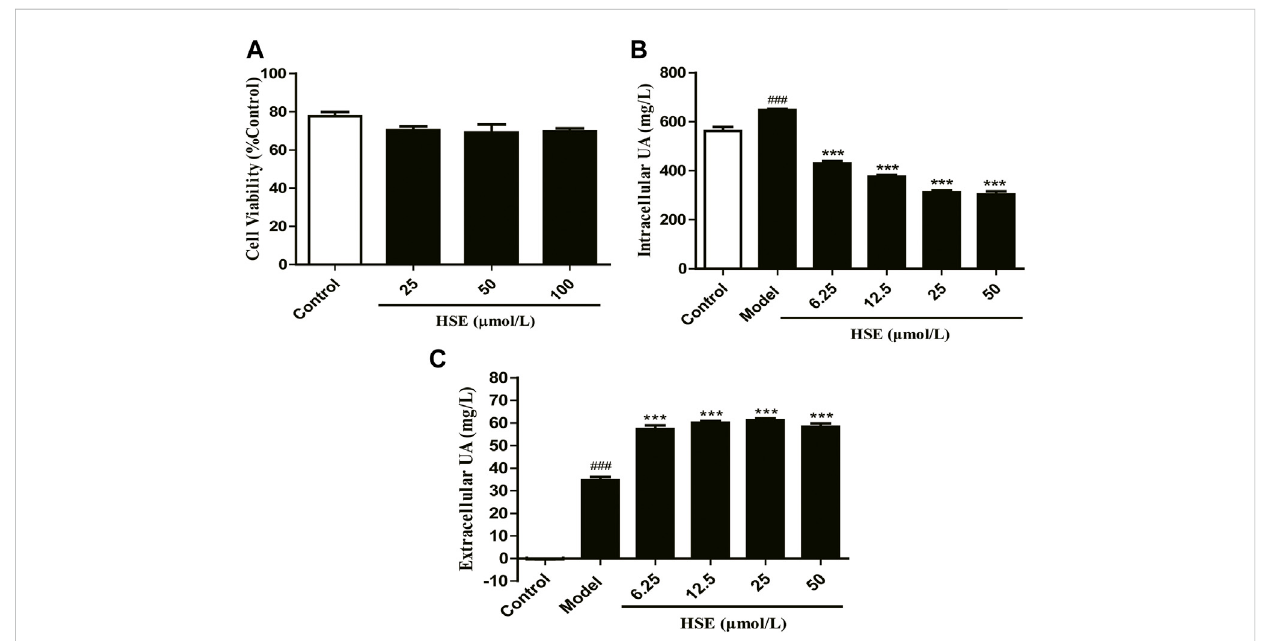
FIGURE 9 Hesperetin(HSE)promoteduricacid(UA)excretion invitro .Effectsofhesperetin(HSE)ontheviabilityofHEK293Tcells (A) andintracellularuricacid (UA) level (B) , and extracellular uric acid (UA) level (C) . Data are the mean ± SEM (n = 3) and representative of three independent experiments. ### p < 0.001 versus the control group; *** p < 0.001 versus the model group. HSE, hesperetin; UA, uric